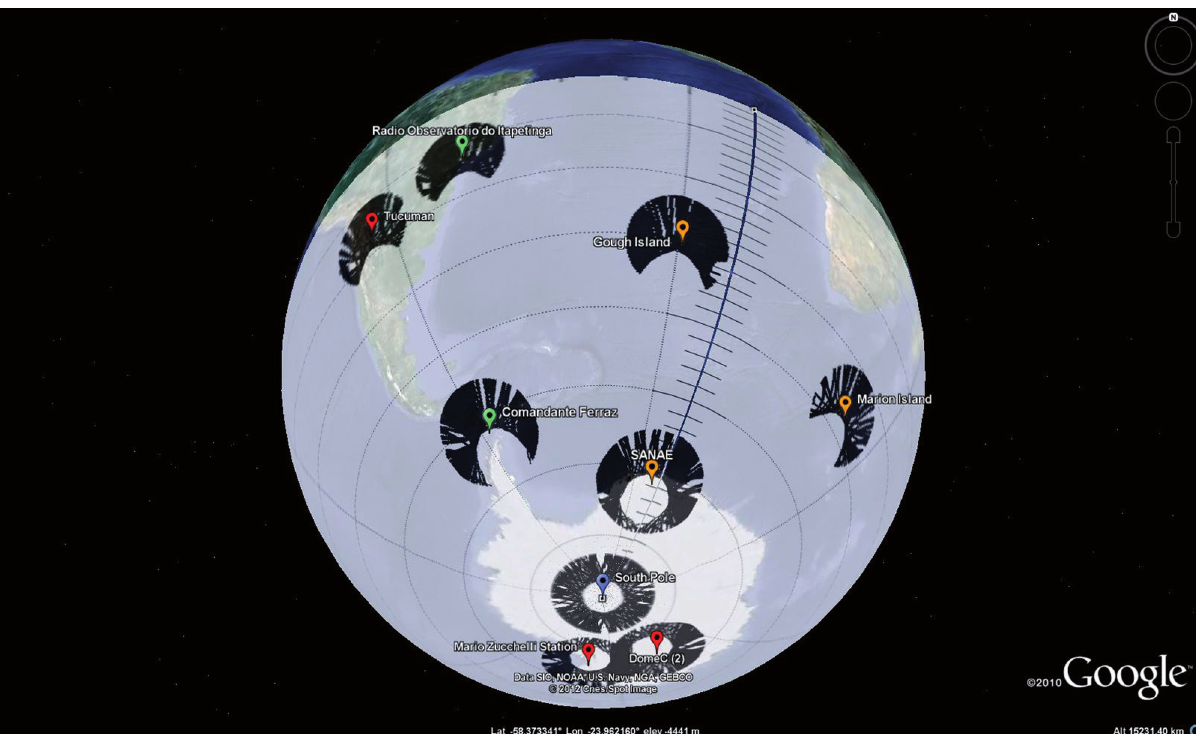
Figure 3. Field of view spanned by the network, obtained by considering all of the data available and applying an elevation angle thresh- old of 20°.